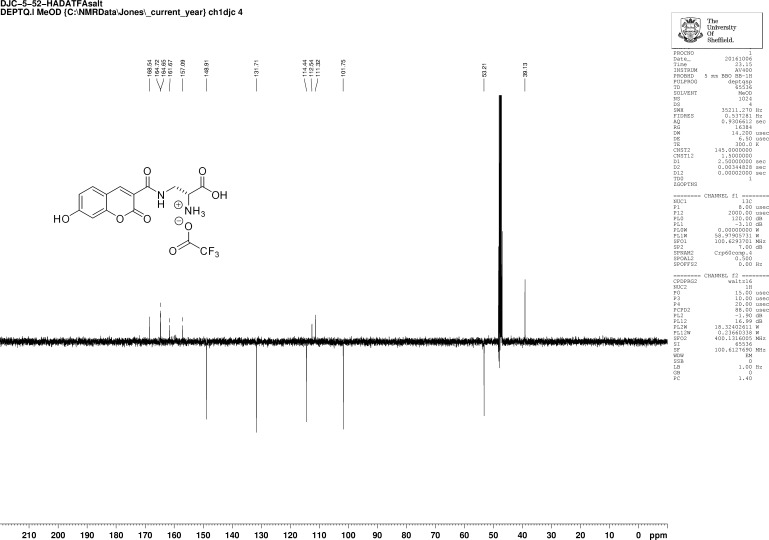
1D 13C NMR Spectrum of 3-{[(7-Hydroxy-2-oxo-2H-1-benzopyran-3-yl) carbonyl] amino} D-alanine, 2,2,2-trifluoroacetate (HADA TFA salt).